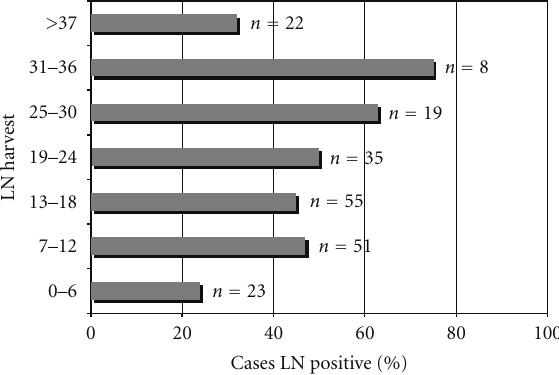
Figure 2: Lymph node harvest and percentage of cases of lymph node